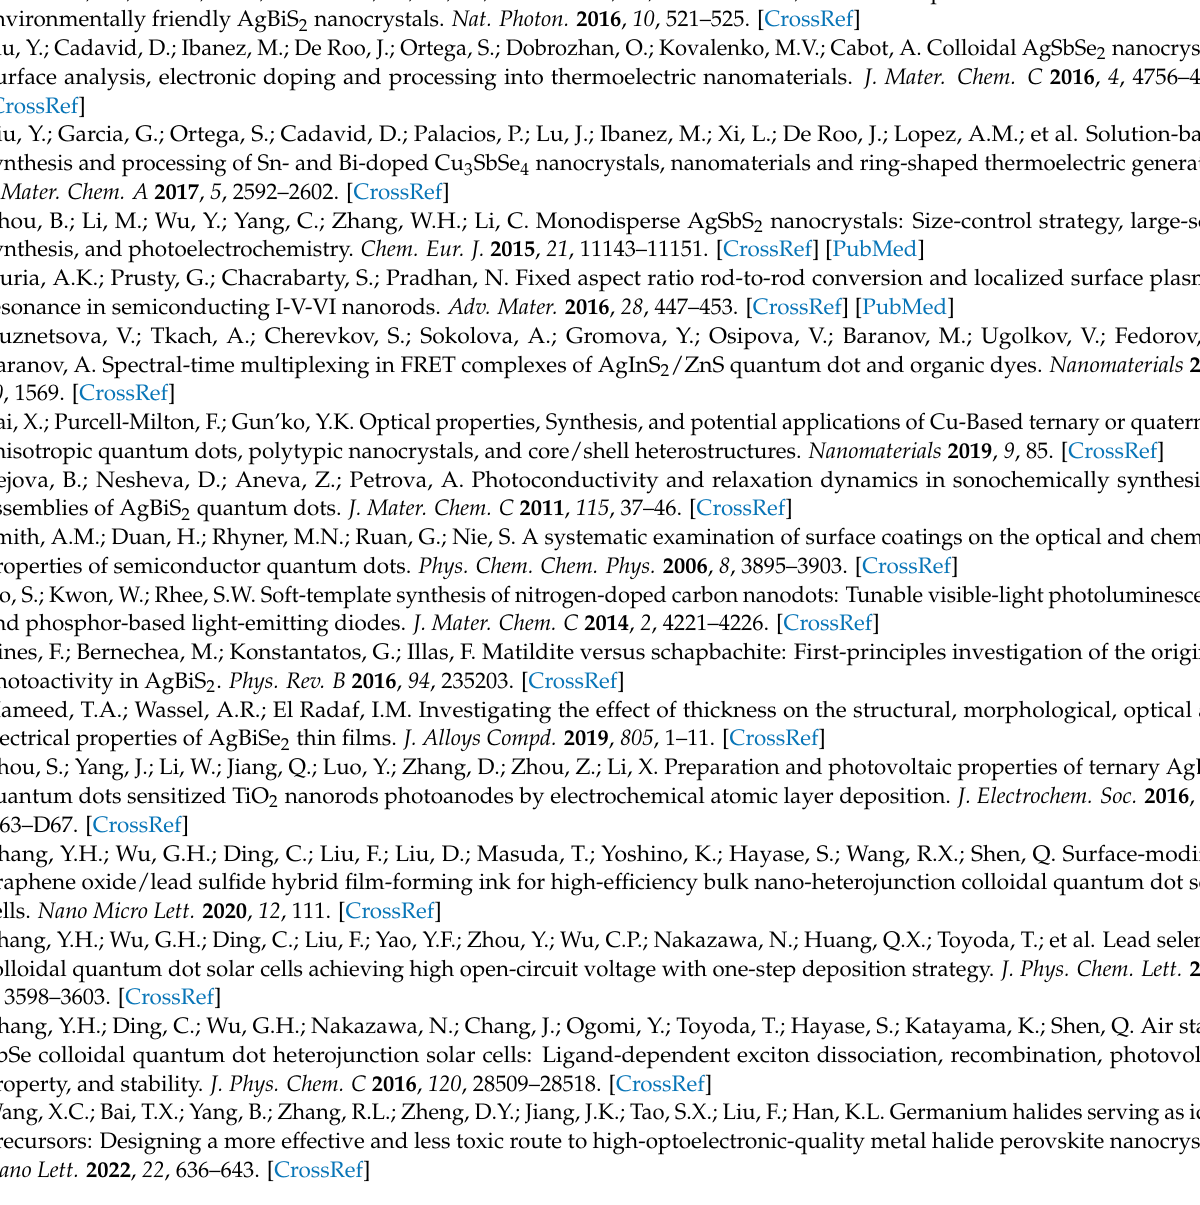
AgBiS 2 NCs. Table S4. Raw material usage, price and yield of AgBiS 2 NCs based on TMS and OLA–S. Reference [60] is cited in the Supplementary